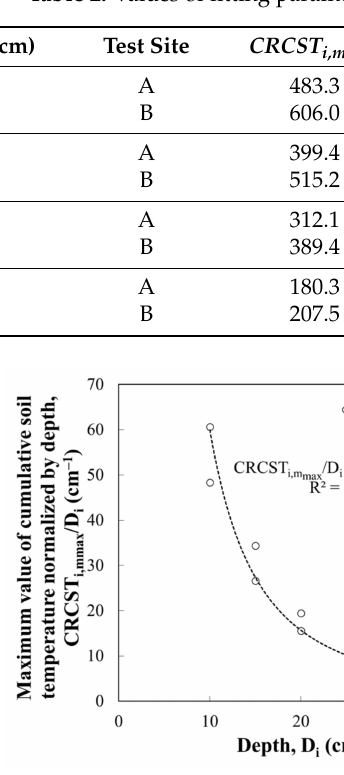
Figure 9. Correlations between the maximum values of cumulative soil temperature ( CRCST i,mmax /D i ) normalized by depth and depth D i